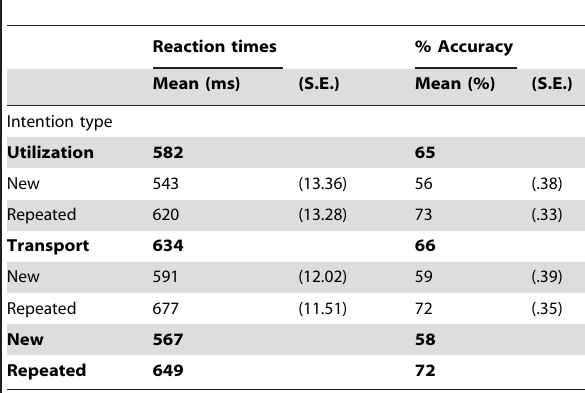
Table 1. Reaction times and accuracy: performance measures across types of intentions (new vs.